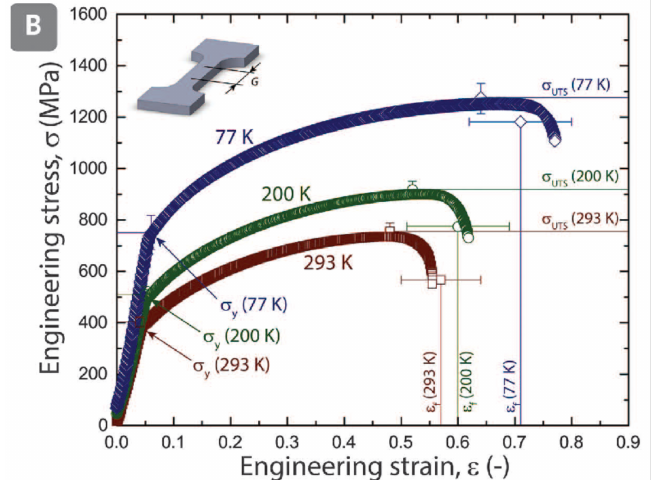
Figure 28. Mechanical properties of a CrMnFeCoNi high entropy alloy: yield strength ( σ y ) , ulti- mate tensile strength ( σ UTS ), and ductility (strain to failure, ε f ) at three temperatures 77, 200 and 293 K, Reprinted with permission from ref. [49]. Copyright 2014 The American Association for the Advancement of Science.